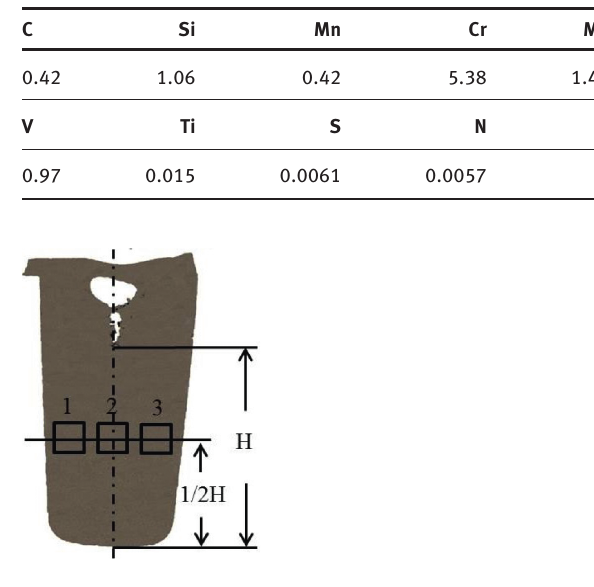
Figure 1: The sampling position.